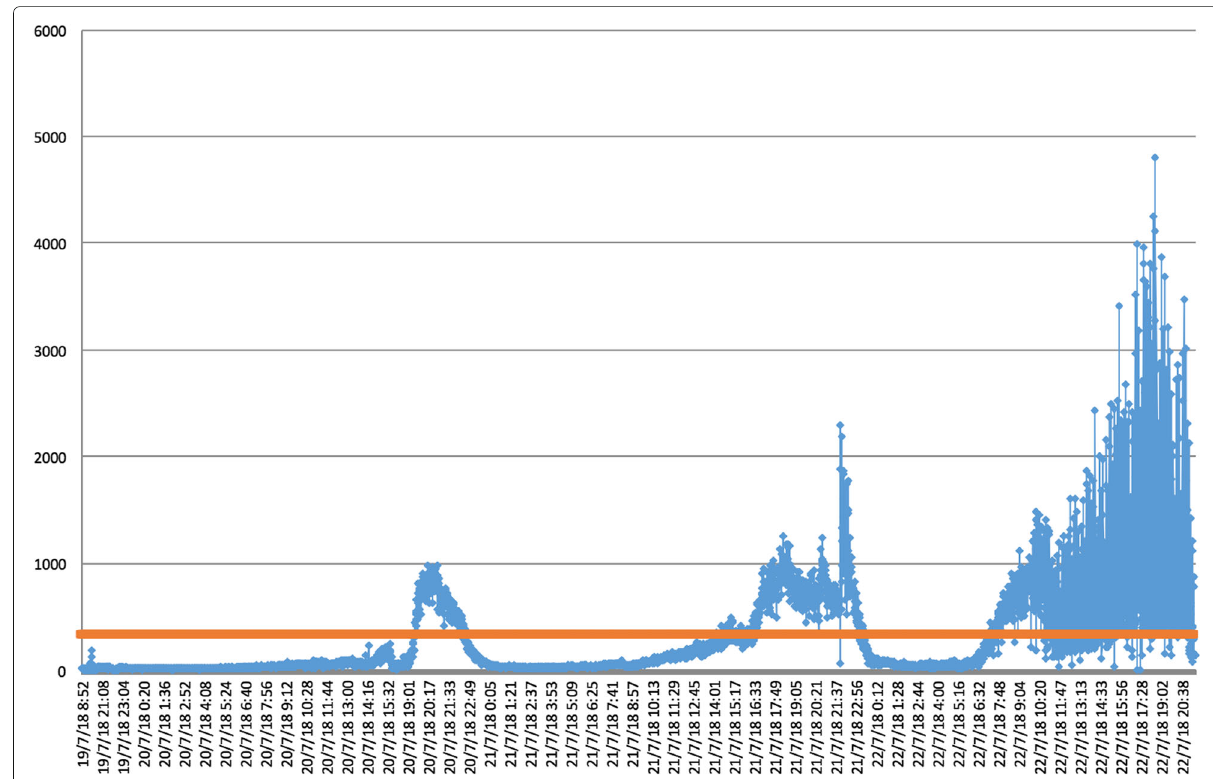
Fig. 4 Unique MAC addresses captured. Unique MAC addresses in the period July 19-22,